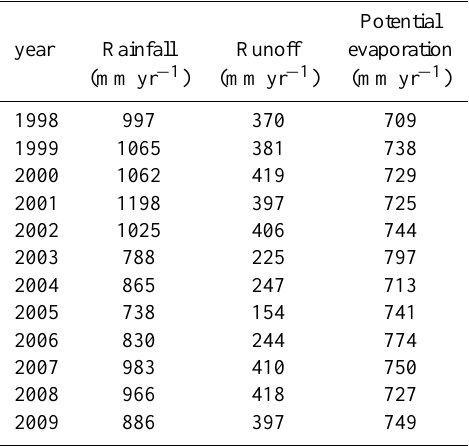
Table 1. Rainfall, runoff and potential evaporation for year 1998 to 2009 for the Wark